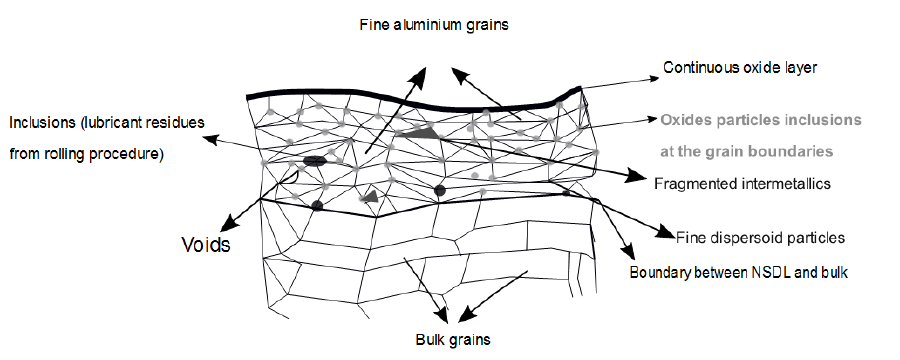
Figure 9. Schematic representation of near surface deofrmed layer. This schematic representation was created based on the thoery of Fishkis et al. Data from